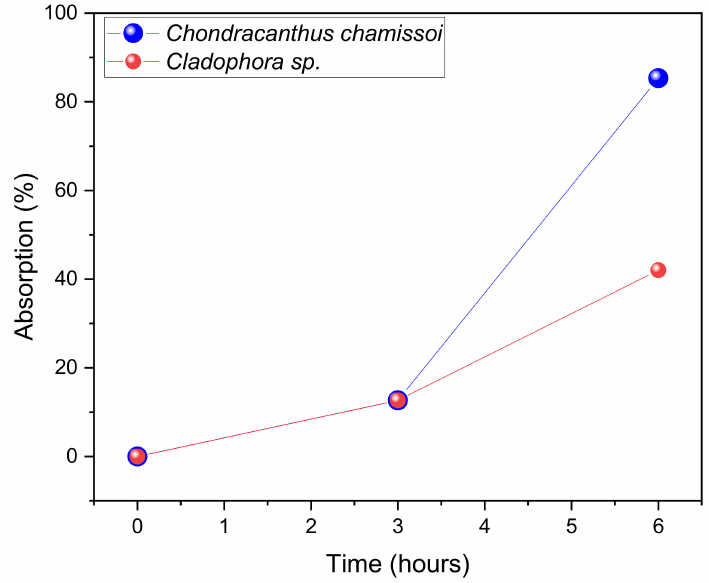
Figure 3. Biosorption percentage of Chondracanthus chamissoi and Cladophora sp. in a 1.50 ppm arsenic solution for 6